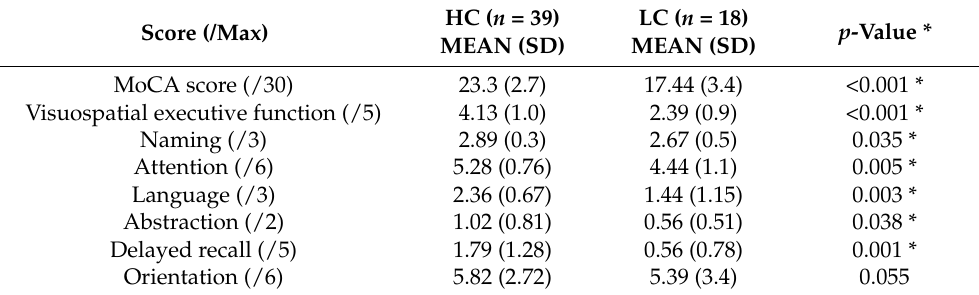
Table 2. Cognitive scores of lower cognition and healthy control